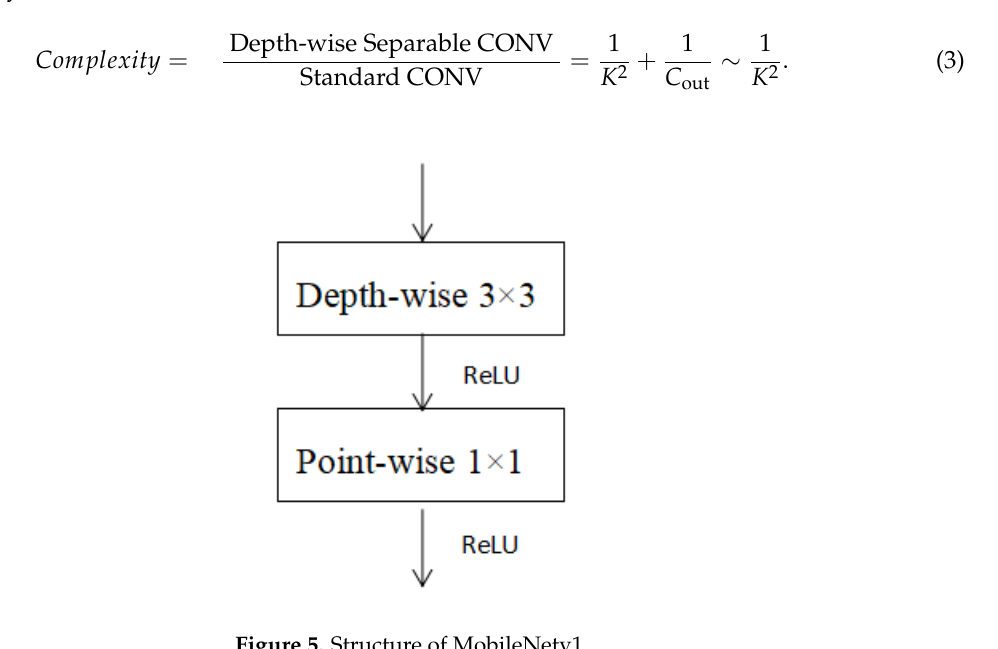
Figure 5. Structure of